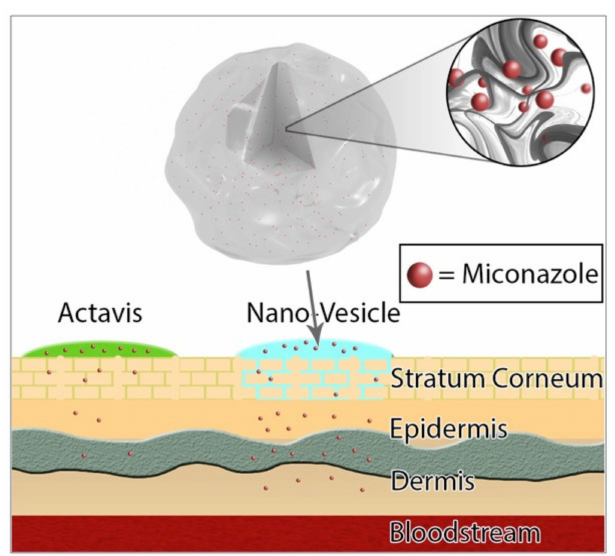
Figure 1. Miconazole loaded nano-vesicles o ff er a higher delivery of drug content through the epidermis to the target site of fungal infection. The high lipid content of the nano-vesicles allows the drug to be carried through the stratum corneum and o ff ers a previously unattainable avenue of drug delivery in high content for lipophilic nano-sized